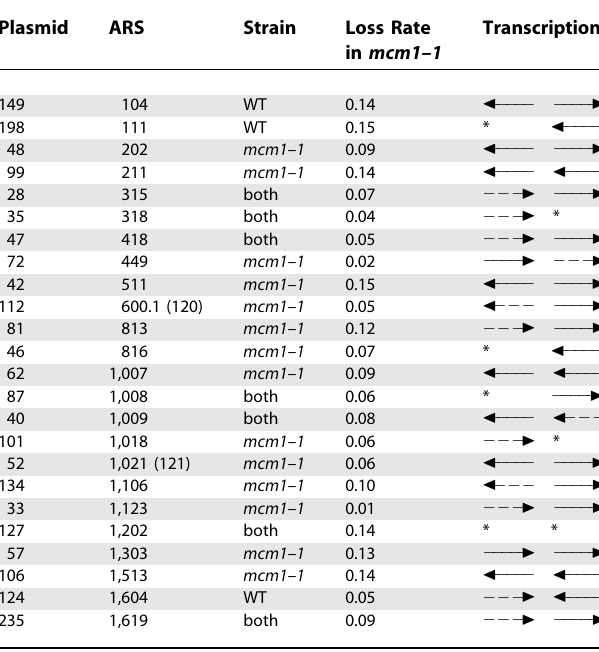
Table 3. Characterization of Stable Plasmids Containing A-Type ARSs